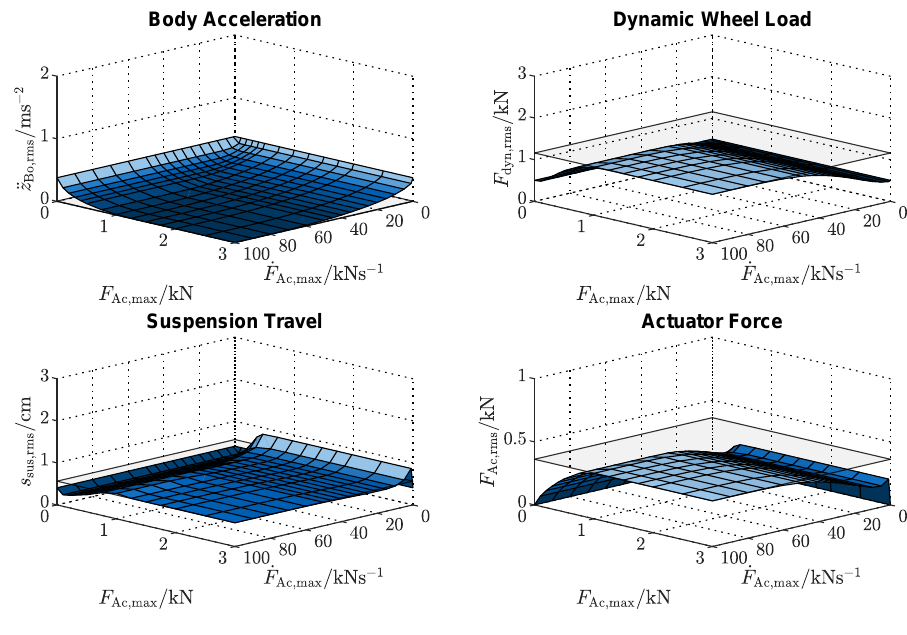
Figure 12. RMS surface plots for the 45kmh − 1 AB profile scenario.